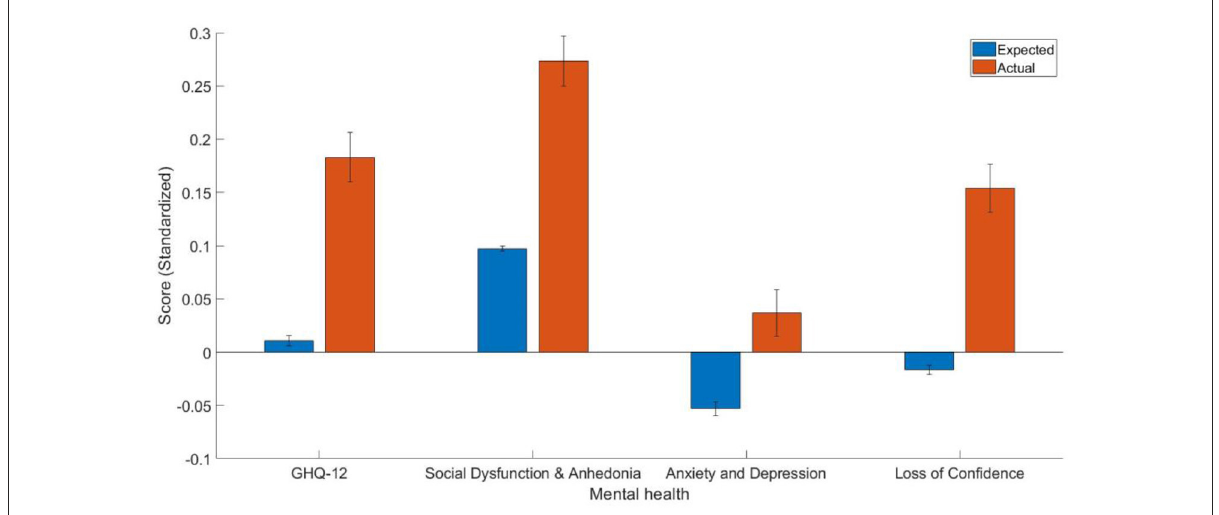
FIGURE1 The mean and standard error of the estimated GHQ-12 summary score and three-factor scores